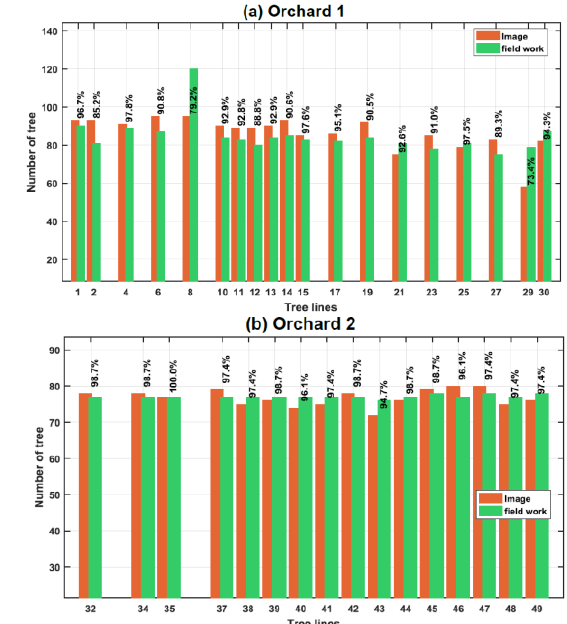
Figure 10. Number of image-detected trees vs the actual number of trees for a) Orchard 1 and b) Orchard 2. The figure represents the accuracy between the image- based and measured tree numbers for each